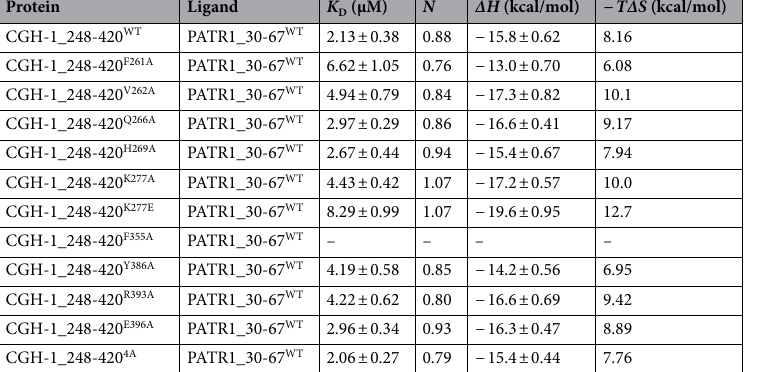
Table 2. Thermodynamic parameters of the CGH-1 248–420 (or its mutants) bound to its ligand Ce PATR-1 30–67 by ITC